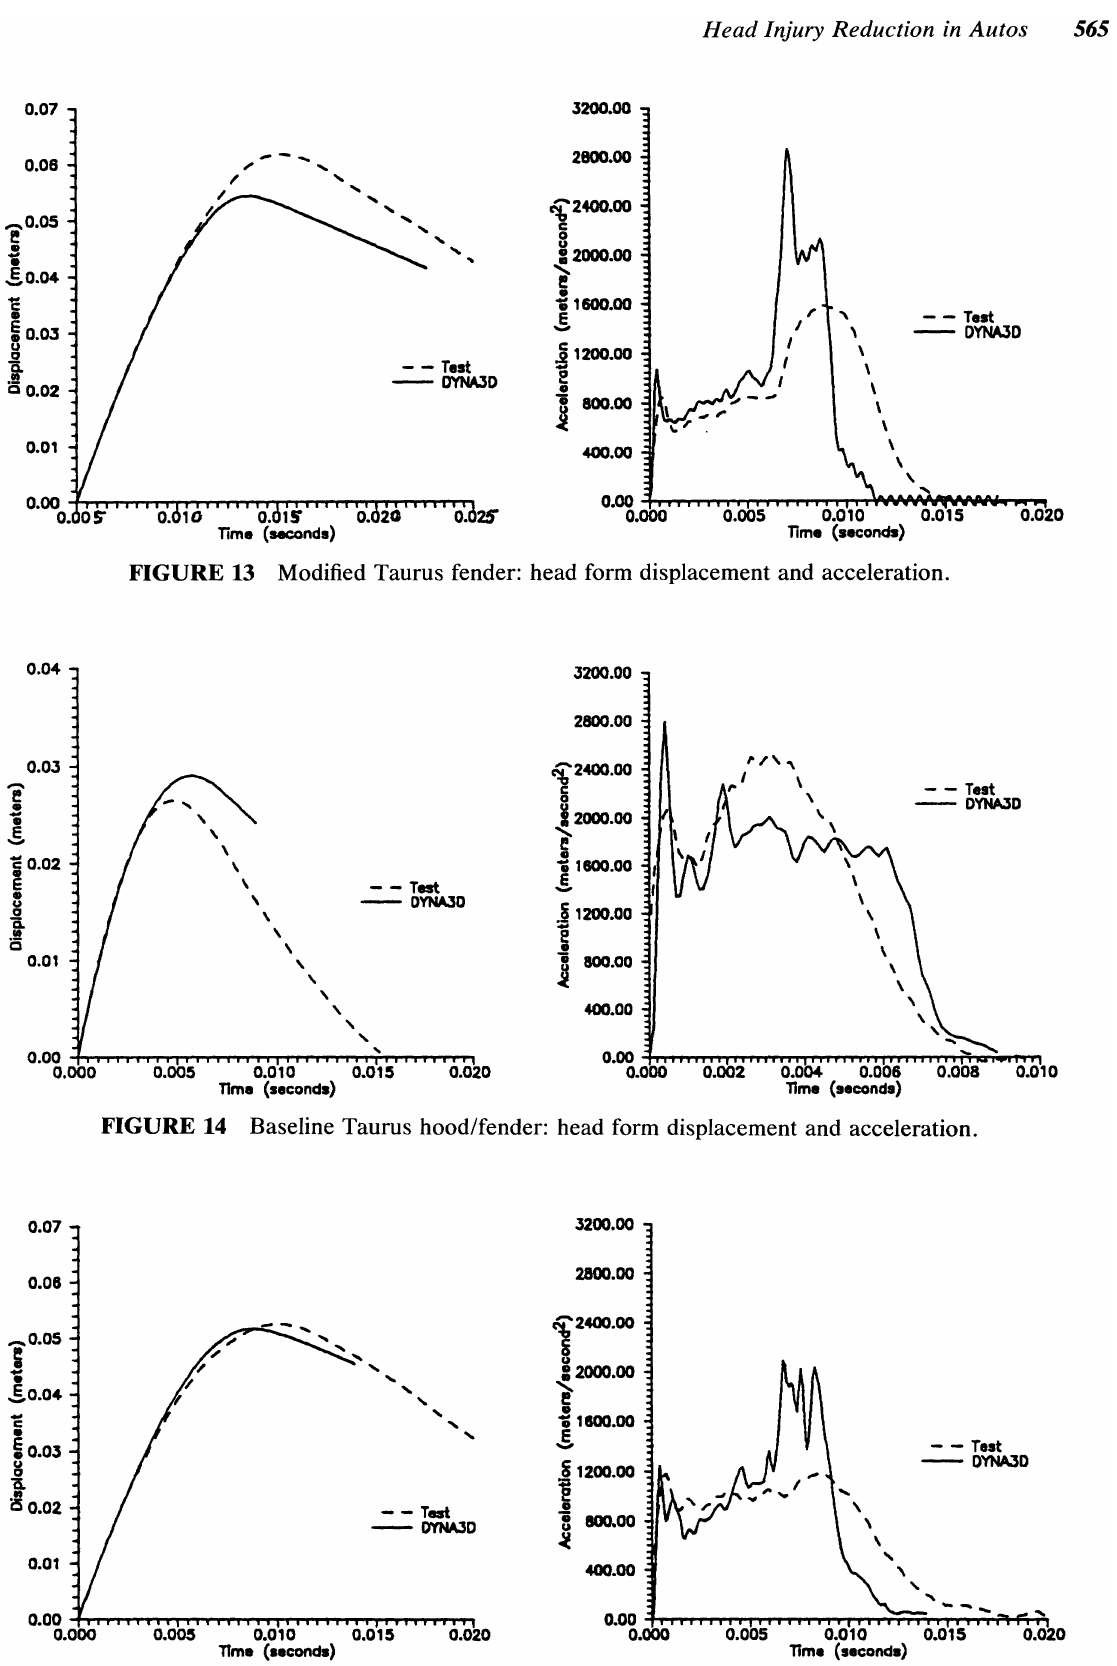
FIGURE 15 Modified Taurus hood/fender: head form displacement and